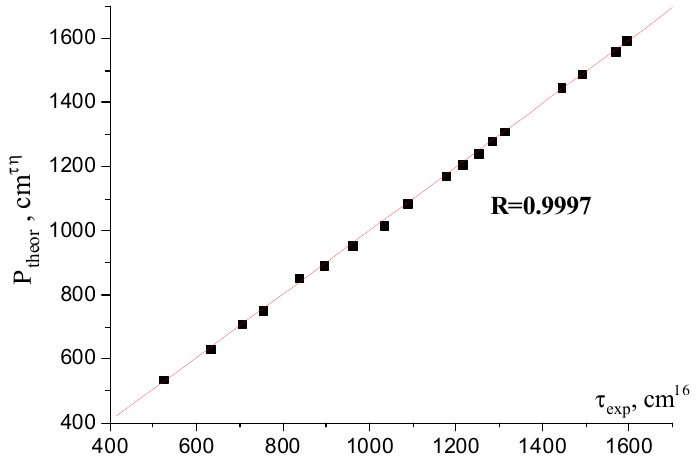
Figure 8. Correlation ω theor vs. f( ν exp ).